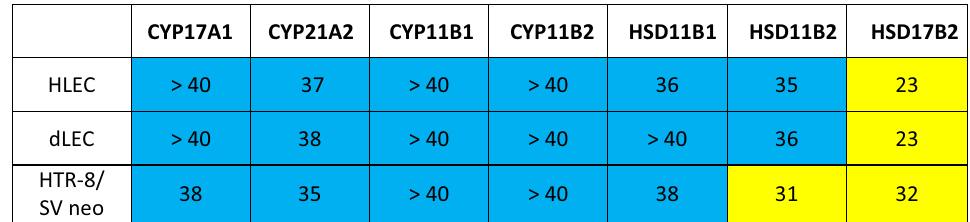
Table 5. Gene expression analysis in HLEC, dLEC and HTR-8/SVneo. mRNA expression of steroidogenic enzymes involved in de-novo steroid hormone production in HLEC, dLEC and HTR-8/SV neo. Expression levels are shown as ct values per 12.5 ng cDNA. Yellow: significant expression (ct < 35). Blue: no or very low expression (ct ≥ 35). CYP17A1 (steroid-17α-hydroxylase), CYP21A2 (steroid-21-hydroxylase), CYP11B1 Appropriate positive and negative controls were